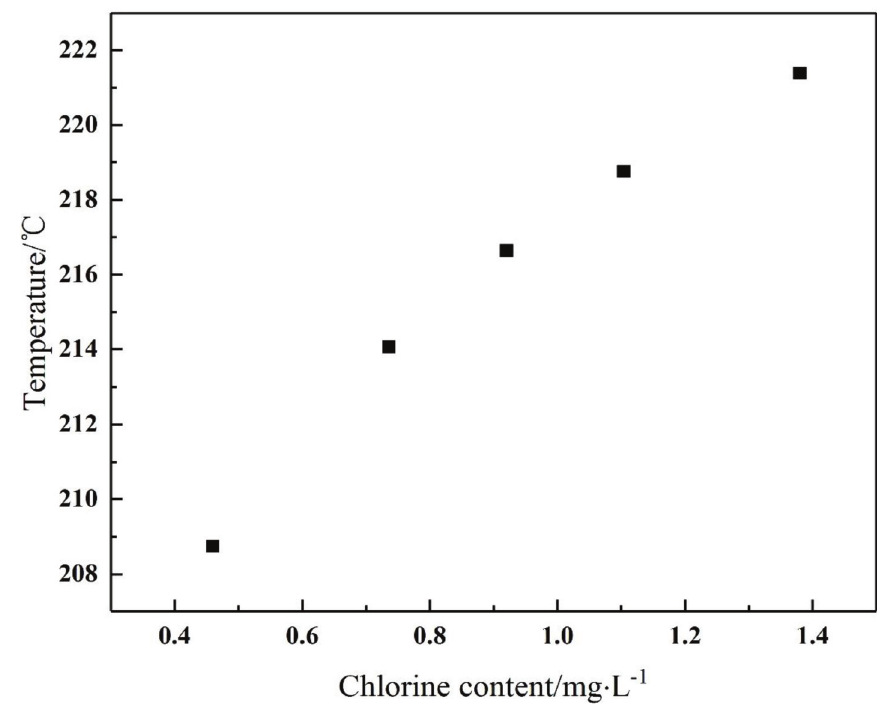
Figure 6. Effect of chlorine content on crystallization